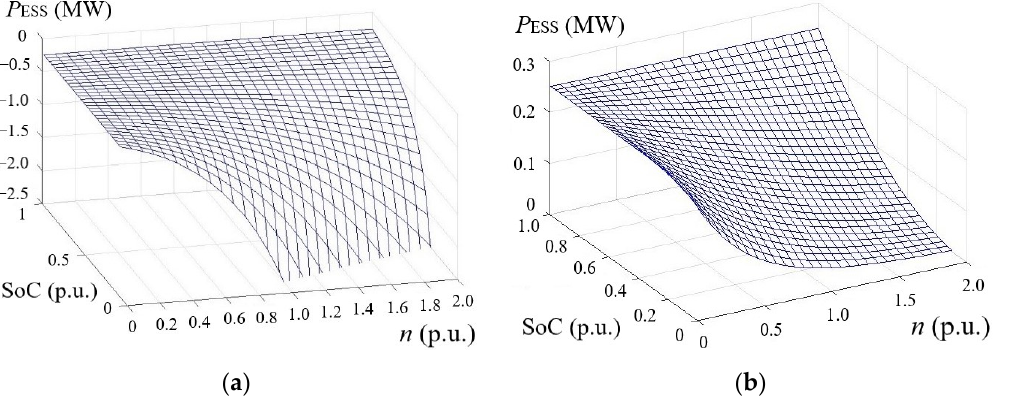
Figure 9. Graphs of the sensitivity of P ESS to changes in n depending on SoC values: ( a )—ESS charging mode; ( b )—ESS discharging mode.